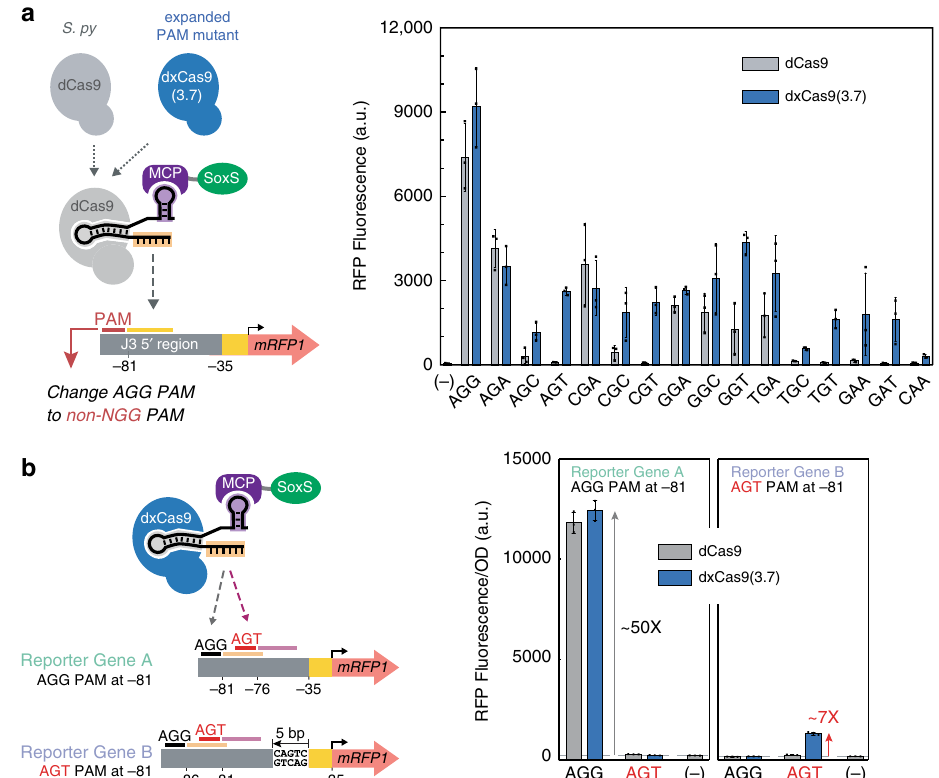
Fig. 5 dxCas9(3.7) expands the range of targetable scRNA target sites by recognizing alternative PAMs. a CRISPRa with dxCas9(3.7) displayed activity on non-NGG PAM sites with AGA, AGC, AGT, CGA, CGC, CGT, GGA, GGC, GGT, TGA, TGC, TGT, GAA, GAT, CAA sequences. CRISPRa activity with dxCas9(3.7) on non-NGG PAM sites was generally lower (6-fold to 89-fold activation relative to a control without a scRNA) compared to the AGG PAM site (188-fold activation). Sp -dCas9 also displayed moderate CRISPRa activity at non-NGG PAM sites with AGA, CGA, GGA, GGC, GGT, TGA sequences,